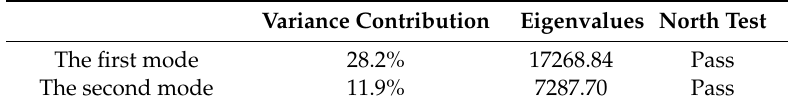
Figure 6. MV-EOF analysis of SST-precipitation in the low latitudes of Pacific. Table 2. Variance contribution and eigenvalues of MV-EOF analysis results for SST-precipitation.